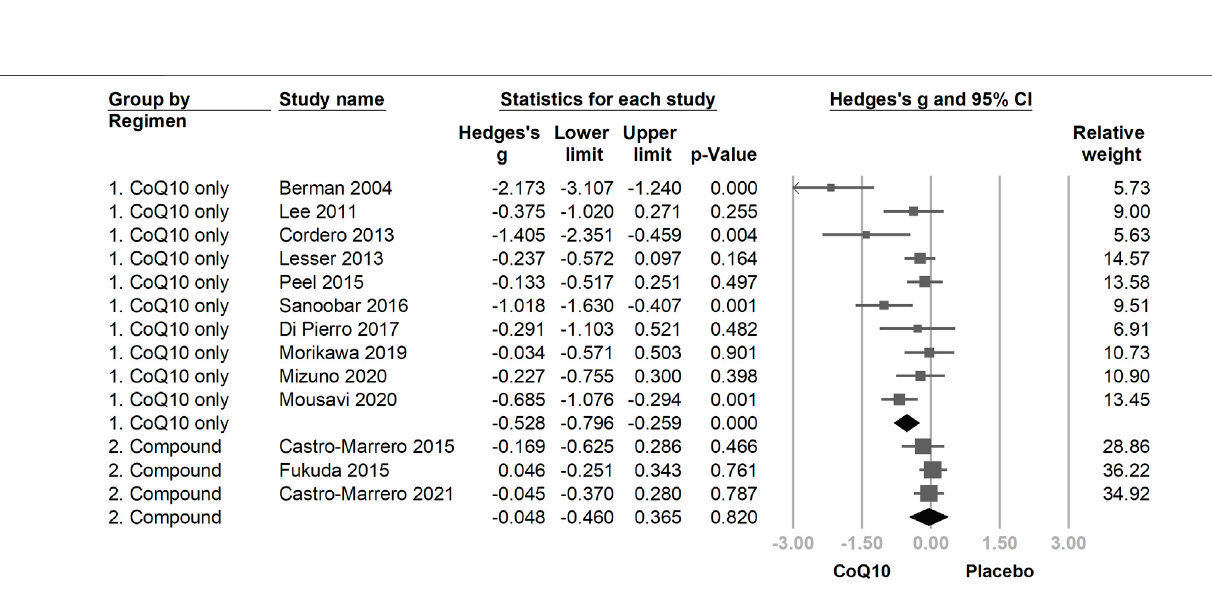
FIGURE6| Theforestplotofsubgroupanalysisusingthecompositionoftheinterventionalregimen,includingCoQ10onlyandCoQ10compoundinterventionsas themoderators.CoQ10iseffectiveinreducingfatigueintheCoQ10-onlyformulation,butnotinthemixingcompound, whichmightbeassociatedwiththelowerdoseof CoQ10 used in compound